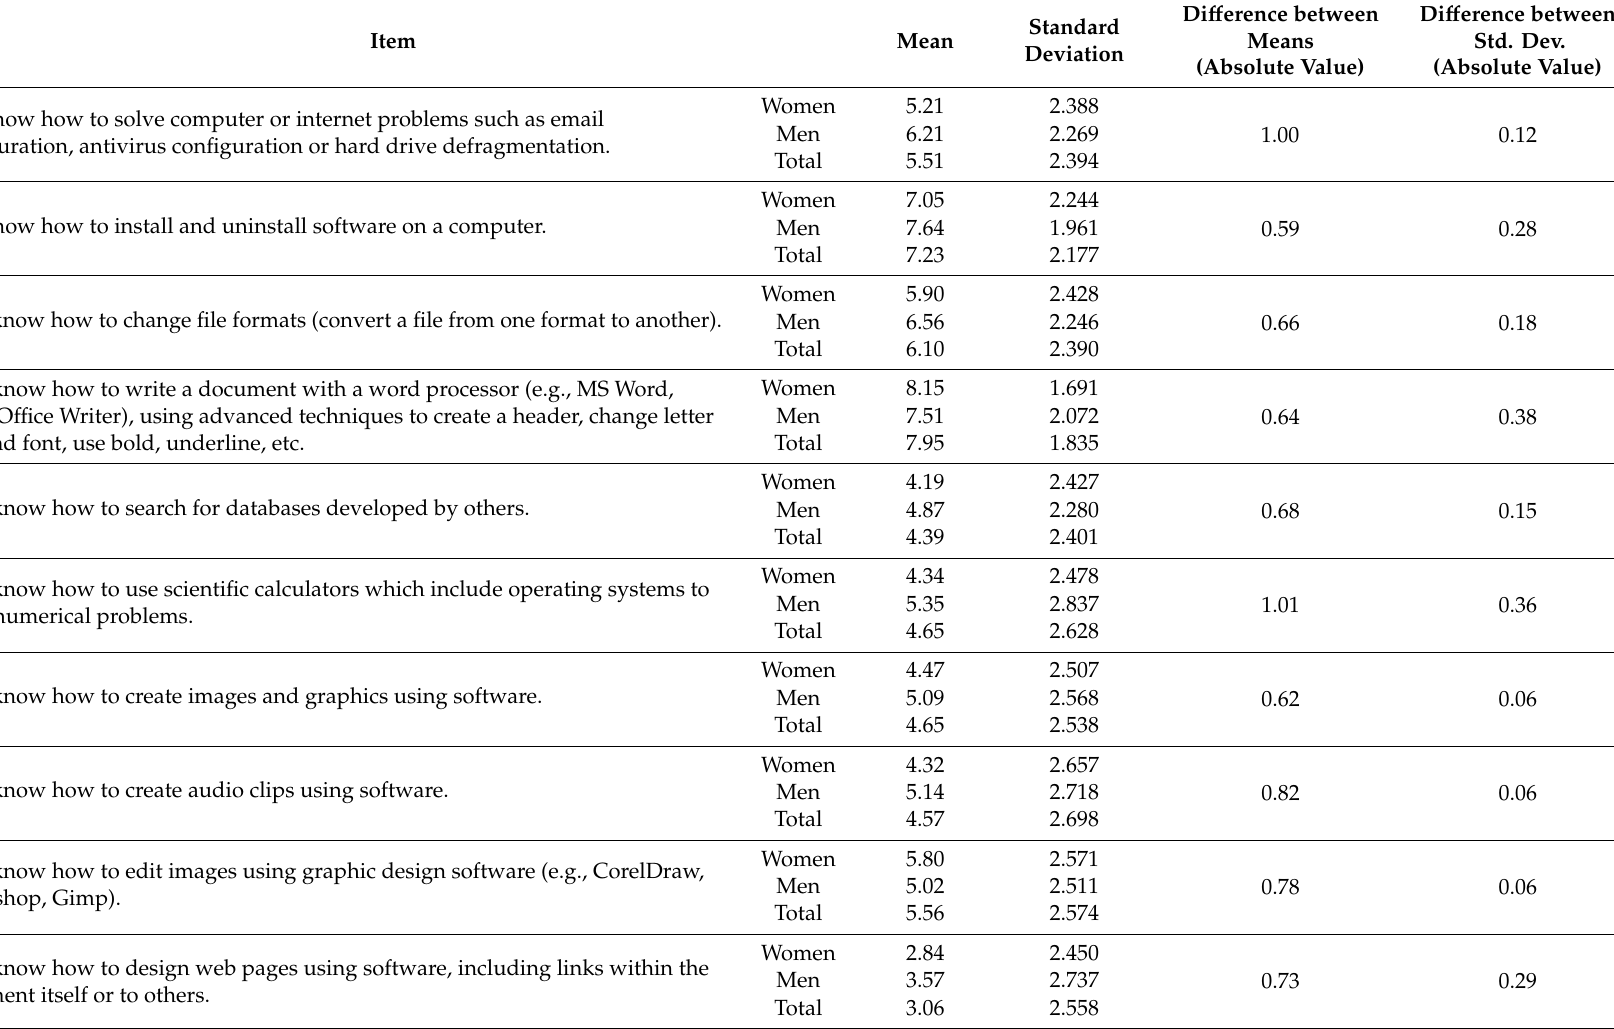
Table 4. Comparison of means by gender. Item Mean